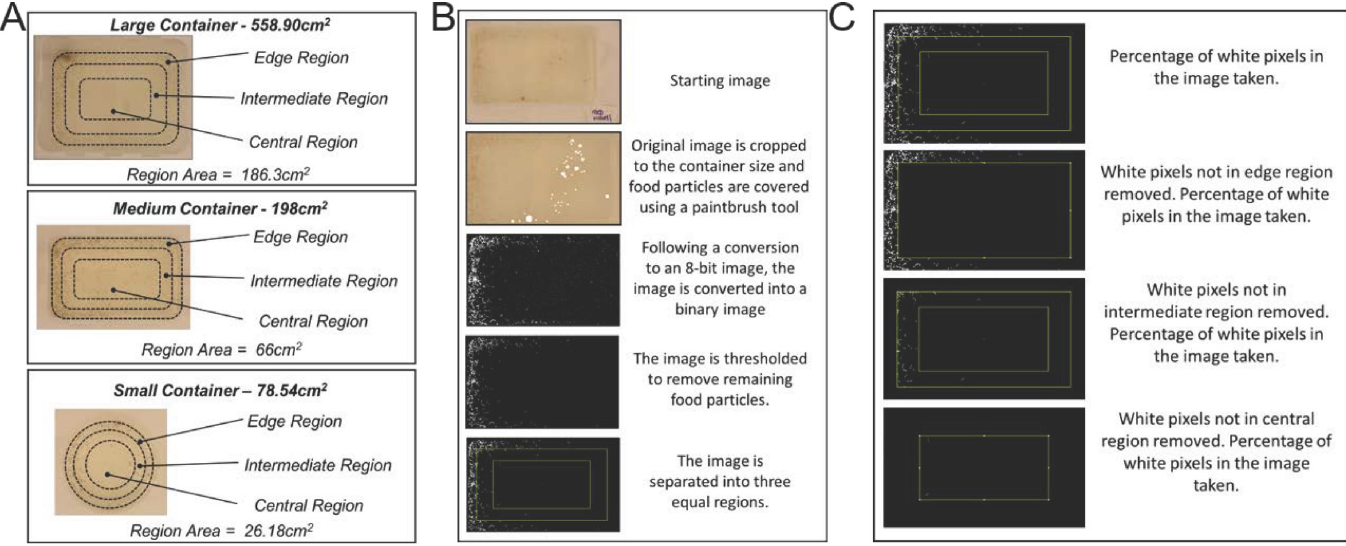
Fig 1. A. The relative areas of the three regions for each of the differing container sizes. Container sizes are labelled with the relative area size for their three regions. Large containers had regions measuring 186.30 cm 2 , for medium containers 66.00 cm 2 and for small containers 26.18 cm 2 B. Processing of images to allow counts for each region. C. Example of calculation of percentage of larvae in outer, intermediate, and central